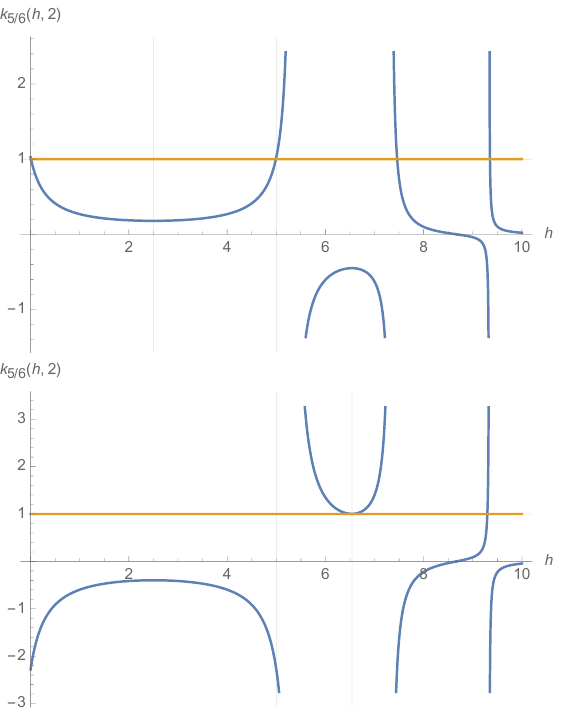
( h, 2) of the ladder kernel when the conformal dimension h Figure 6 . Left: the eigenvalues k 5 / 6 crosses the unitarity bound h = 5 , at g = 19 . 3 . It merges with its shadow at h = 5 / 2 , when g = 45 . 7 . Right: merging of the conformal dimensions h 0 , 2 and h 1 , 2 at h = 6 . 54 , when g = i 28 . 8 . The vertical lines in light grey are again a guide for the eye, to show the unitarity bound and the abscissa of the